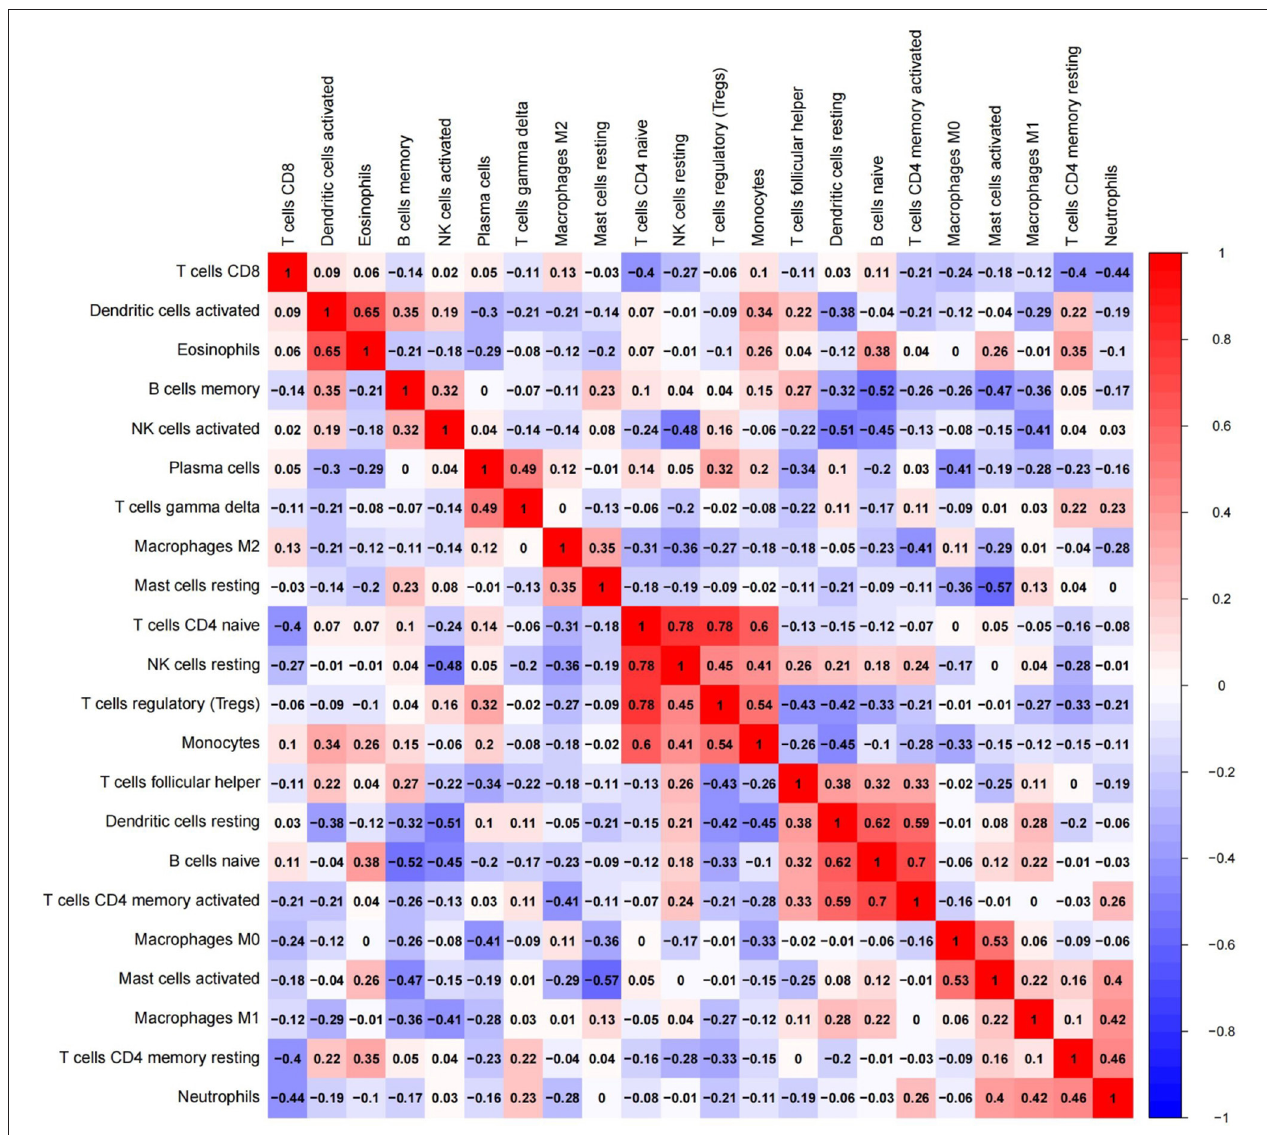
FIGURE 6 | Red: there might be a positive correlation between the two immune cells; blue: there might be a negative correlation between the two immune cells.